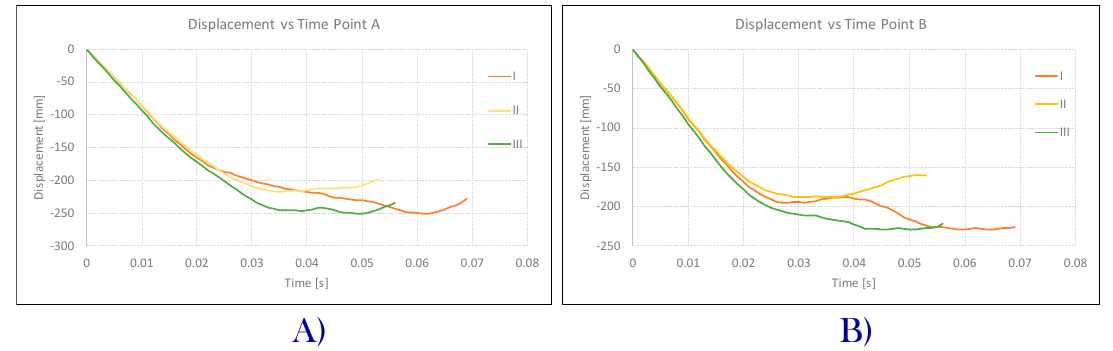
Figure 10. Displacement vs. time for the three considered configurations: ( A ) Point A location. ( B ) Point B location.